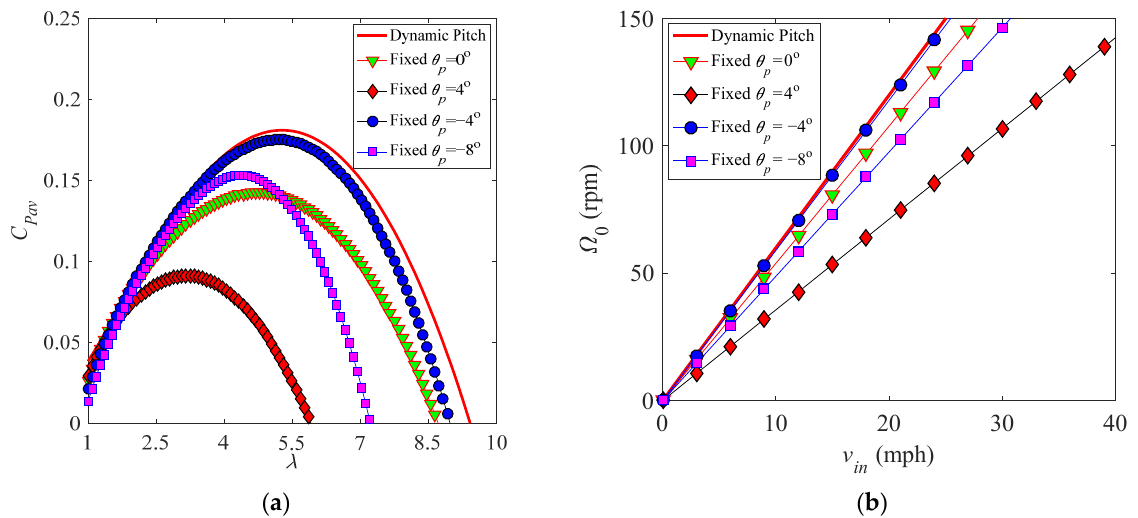
Figure 22. Optimization principle of the blade: ( a ) the power coefficient versus the tip-speed ratio; and ( b ) the optimal rotational speed versus the incoming wind speed.